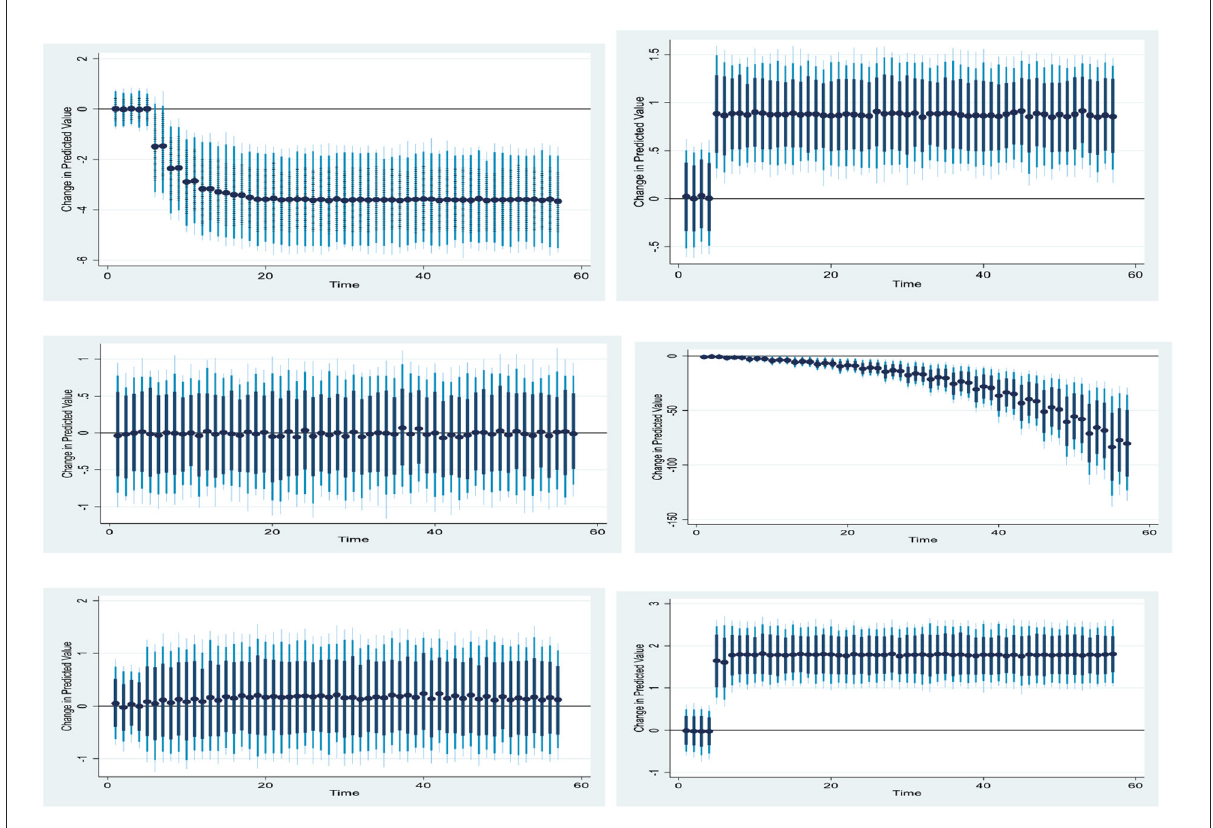
FIGURE3 Graph for dynamic